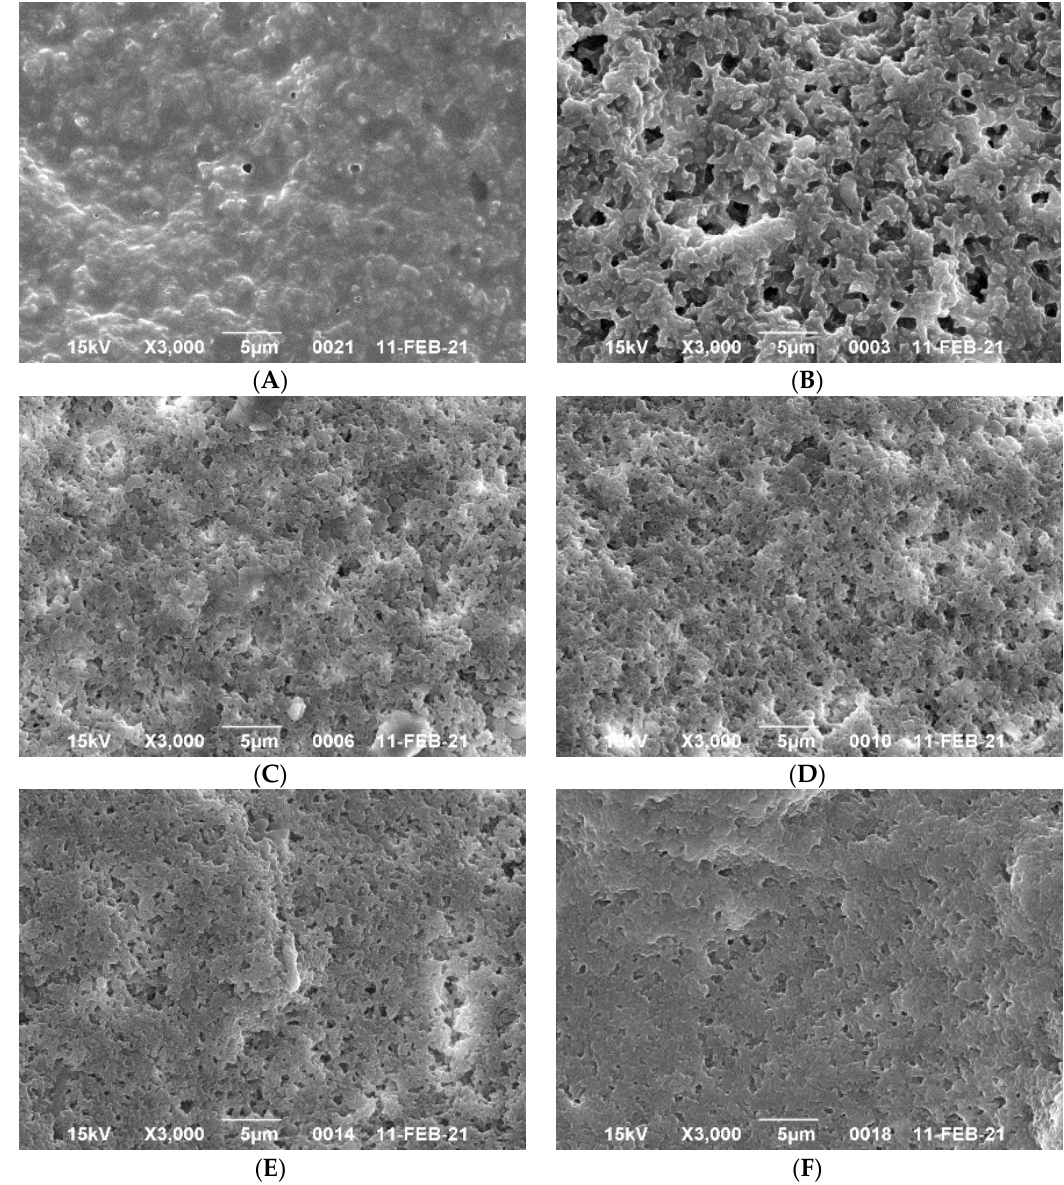
Figure 4. Scanning Electron Microscopy (SEM) photographs of yogurt samples. ( A ) FFY = full-fat yogurt produced from whole milk powder (WMP); ( B ) NFY = non-fat yogurt produced from skim milk powder (SMP); ( C ) NFYWPI-3 = SMP was replaced by 3% WPI; ( D ) NFYWP-5 = SMP was replaced by 5% WPI; ( E ) NFYWP-7 = SMP was replaced by 7% WPI; ( F ) NFYWP-9 = SMP was replaced by 9%